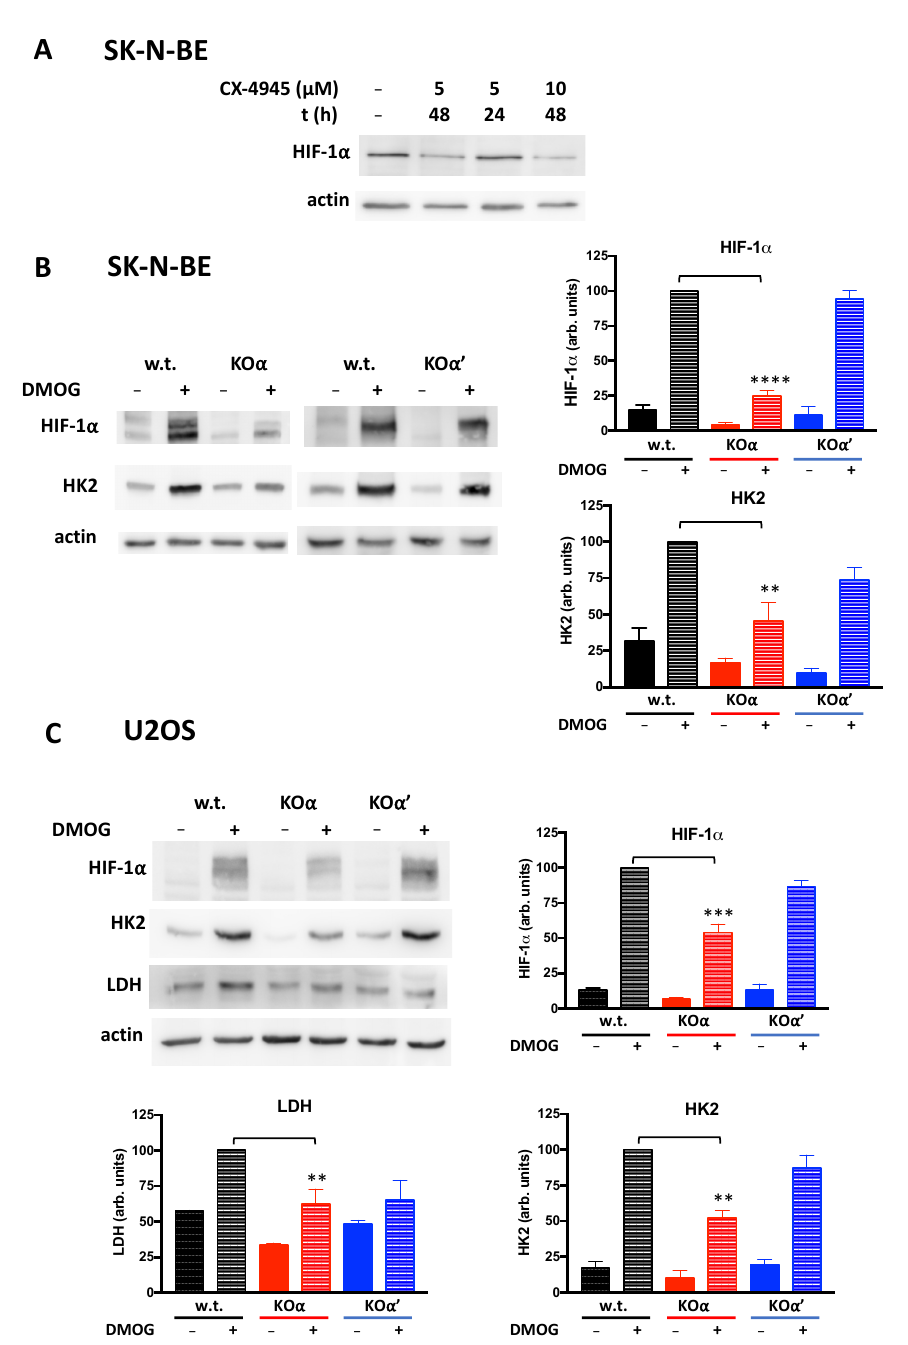
Figure 6. HIF-1 α levels in w.t. and KO clones of SK-N-BE and U2OS cells. ( A ) w.t. SK-N-BE cells were treated with CX-4945 at the indicated time and concentration conditions. 30 µ g proteins from lysates were analyzed by WB for the HIF-1 α levels. Actin was used as loading control. ( B ) SK-N-BE cells (w.t or KO α clone 1, or KO α ’ clone 1) or ( C ) U2OS cells (w.t or KO α clone 1 or KO α ’ clone 2) were treated, where indicate (+), with 2mM dimethyloxallyl glycine (DMOG) for 20 h. 30 µ g proteins from cell lysates were analyzed by WB for the indicated proteins. Actin was used as loading control. At least three independent experiments (also with different clones) were performed. Representative WB are shown. The bar graphs report quantification of HIF-1 α , HK2 and LDH, as normalized mean values ± SEM of all experiments, in arbitrary units, obtained by analyses with Kodak 1D Image software. Significance refers to the corresponding condition in w.t. cells. (**) p < 0.01, (***) p < 0.001, (****) p <